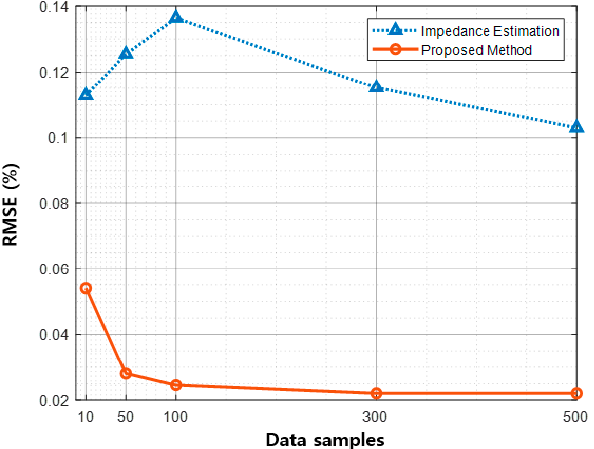
Figure 13. Effect of the data sample on the voltage prediction at 0.97 (p.u) slack node voltage.